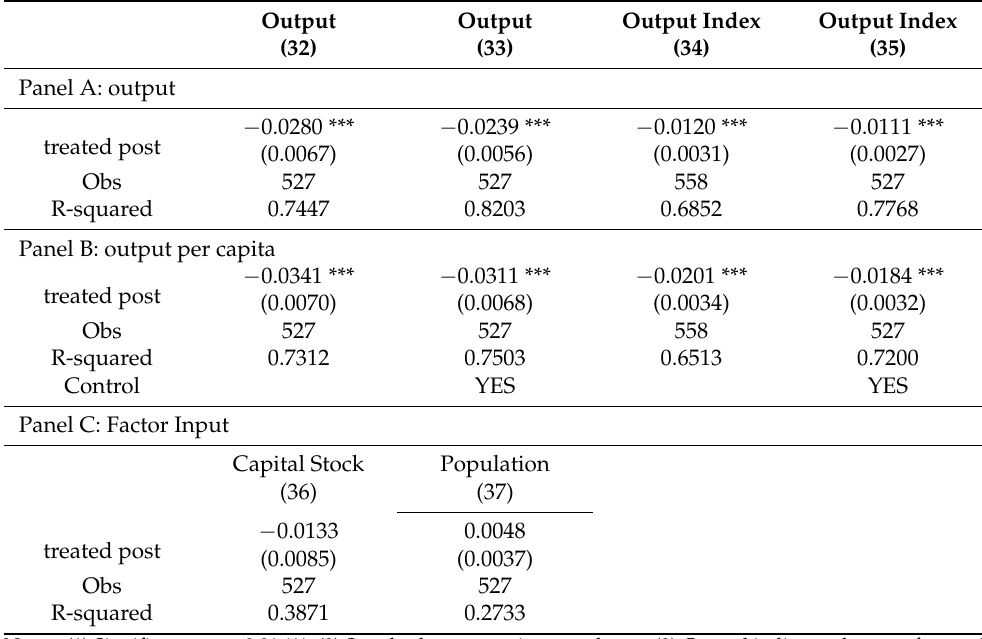
Table 6. Long term economic impact of epidemic reaction